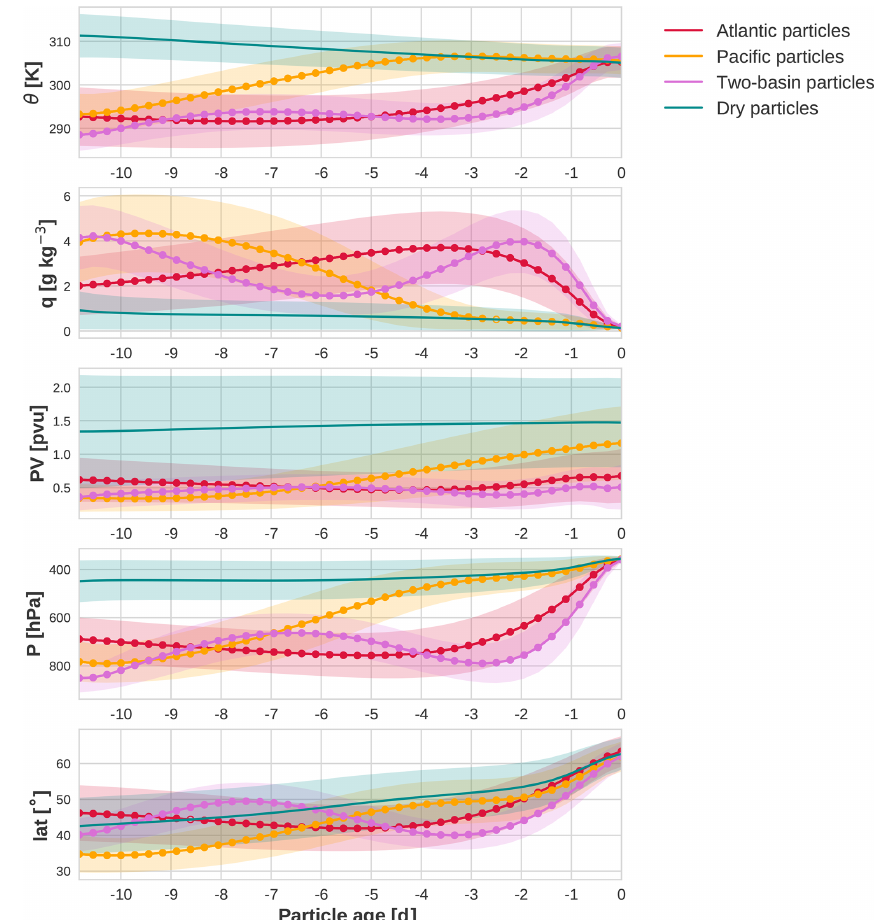
Figure 8. Same as Fig. 5 but with moist particles being categorized according to their moisture sources: Atlantic particles (red), Pacific particles (orange), and two-basin particles (magenta). Cyan denotes the properties for the dry